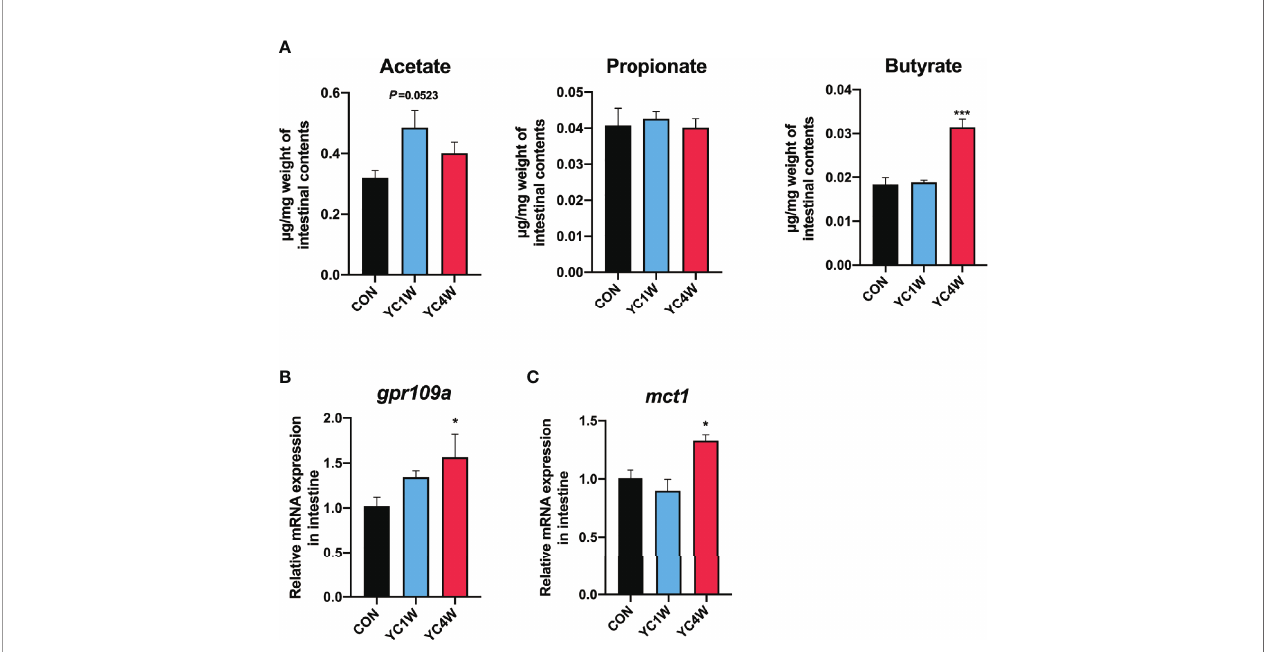
FIGURE 3 | Gut microbiota alteration induces the accumulation of gut butyrate. (A) Intestinal short-chain fatty acid levels in CON, YC1W, and YC4W groups ( n = 3). (B) Relative mRNA expression of butyrate-sensing receptor gene gpr109a and (C) butyrate transporter gene mct1 in zebra fi sh intestine ( n = 6). Data are presented as mean ± SEM. * p < 0.05; *** p < 0.001 by one-way analysis of variance followed by Dunnett ’ s multiple comparisons